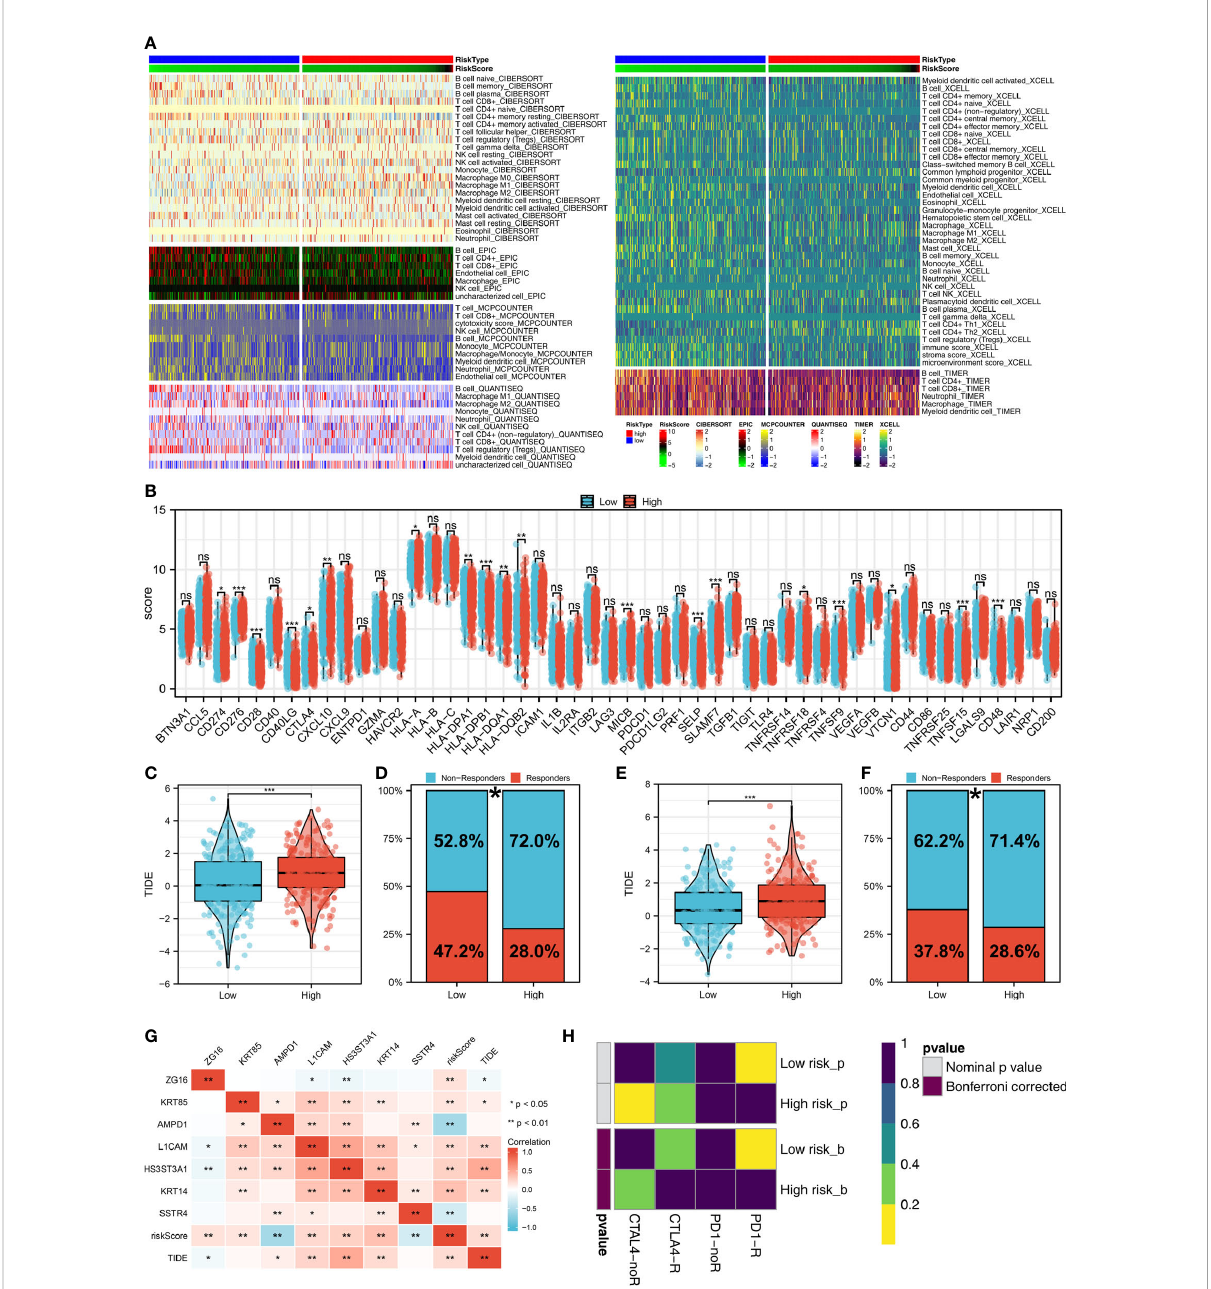
FIGURE 6 Immune-related analysis. (A) The correlation between risk score and various immune scores; (B) The expression level of immune-related genes in low- and high-risk groups, ns P > 0.05, *P < 0.05, **P < 0.01, ***P < 0.001; (C) The level of TIDE score in low- and high-risk groups in the TCGA cohort, ***P < 0.001; (D) Percentage of immunotherapy responders and non-responders in patients with high and low risk score (TCGA cohort), *P < 0.05; (E) T The level of TIDE score in low- and high-risk groups in the GSE68465 cohort, ***P < 0.001; (F) Percentage of immunotherapy responders and non-responders in patients with high and low risk score (GSE68465 cohort), *P < 0.05; (G) The correlation analysis between TIDE score, risk score and seven characteristic molecules, *P < 0.05, **P < 0.01; (H) The correlation analysis between risk score and the immunotherapy response of PD-1 and